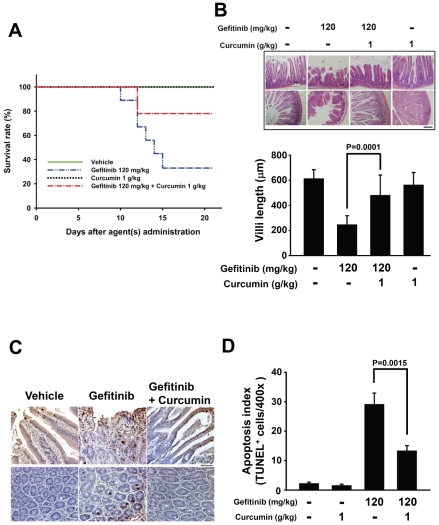
Curcumin attenuates the gastrointestinal adverse effects of gefitinib in vivo.(A) The animal survival rates for each group indicate that curcumin decreased mouse death caused by the adverse effects of gefitinib. (B) H&E staining analysis of intestine sections from each group showing that curcumin prevents villi damage; villi lengths were quantified (bar = 200 µm). Columns, mean (n = 3); bars, SEM. P = 0.0001 (gefitinib versus combination). (C) Apoptosis detection by TUNEL assay using intestine sections from each group. The results indicated that curcumin reduced the TUNEL-positive cells in the villi in the presence of gefitinib. (D) Quantification of TUNEL-positive cells as described in Materials and Methods. Columns, mean (n = 10); bars, SEM. P = 0.0015 (gefitinib versus combination).